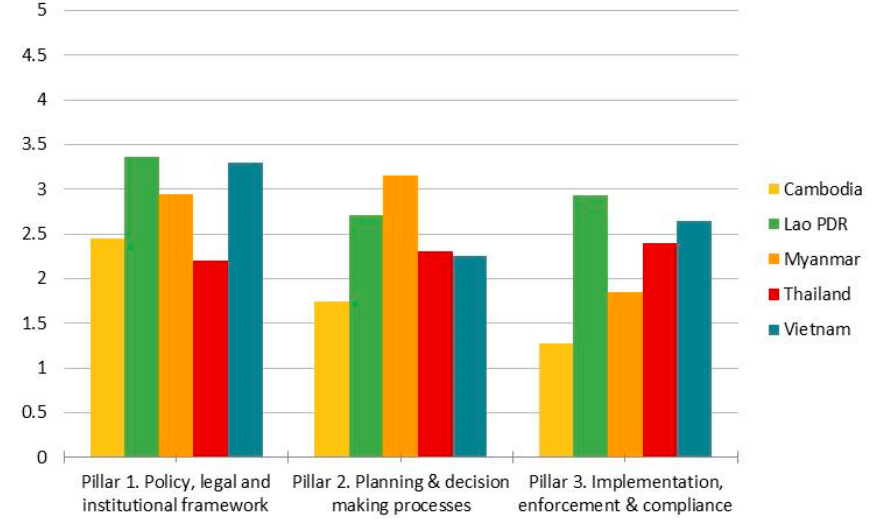
Figure 1. Average score for each country for each pillar.